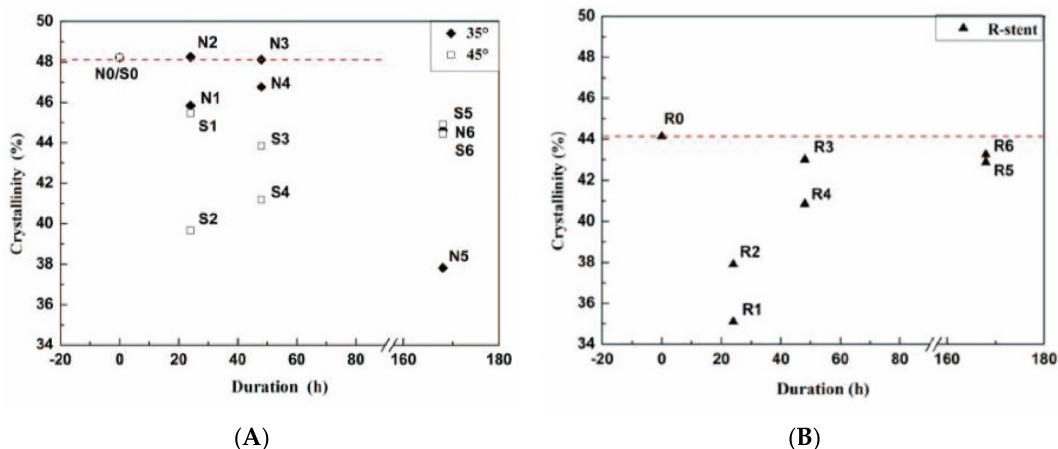
Figure 12. Crystallinity of the polyester in the stent ‐ grafts. After 168 h of twisting, crystallinity was decreased by up to 10% in the Z ‐ stent devices, compared to less than 2% in the ringed–stent devices. ( A ) 35° and 45° Z ‐ stent; ( B ) Ringed stent.